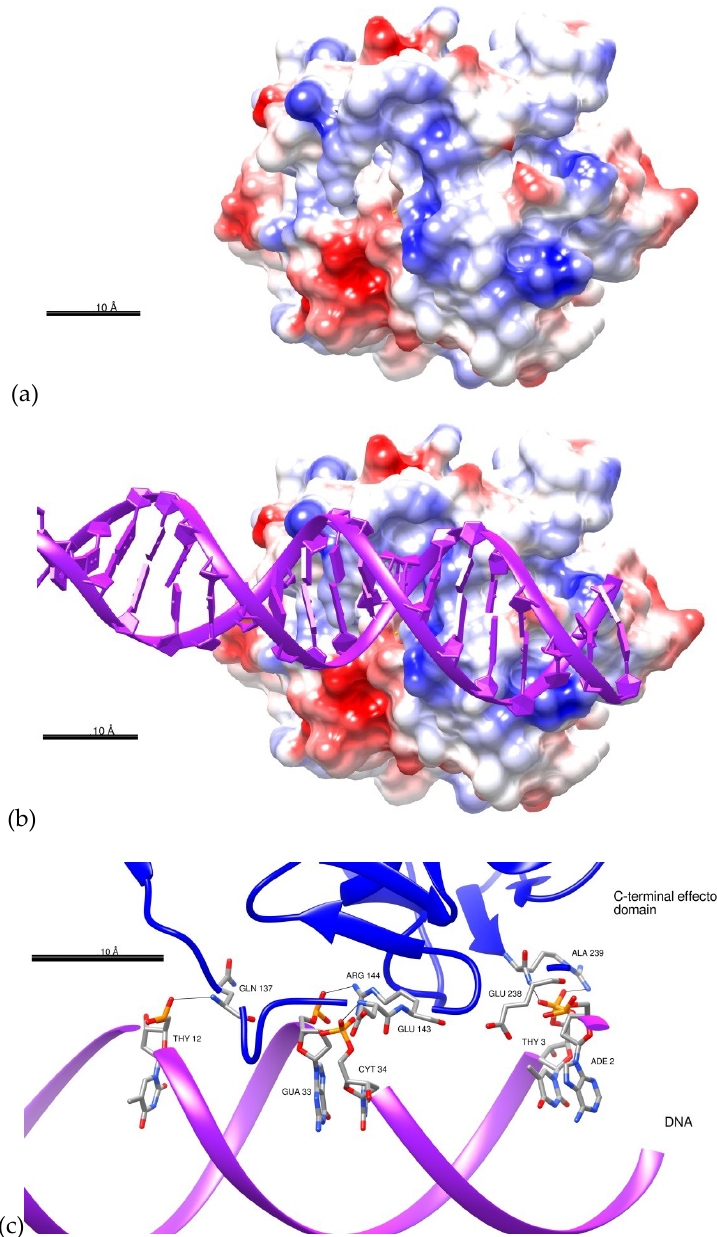
Figure 6. Predicted interactions between the C -terminal effector domain of BvrR and DNA. ( a ) Coulombic surface coloring of the C -terminal effector domain. The areas in royal blue represent surface where energy is 10 Kcal/mol; areas of intense red represents surface where the energy is −10 Kcal/mol, and white areas represent surface where energy is 0 Kcal/mol. ( b ) Coulombic surface coloring of C -terminal effector domain with DNA. ( c ) Intermolecular interactions between C -terminal effector domain (blue) and DNA (purple); HBs are indicated by black lines (Frame 7507). Proteins were represented schematically with Chimera software developed by The National Institutes of Health (NIH) [31].